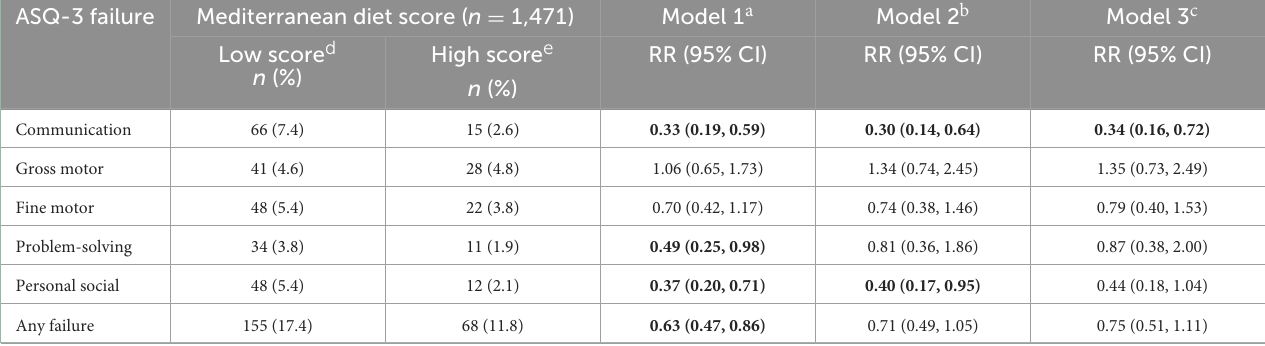
TABLE 2 Associations of Mediterranean diet score during pregnancy with developmental delays in infants at 12 months. ASQ-3